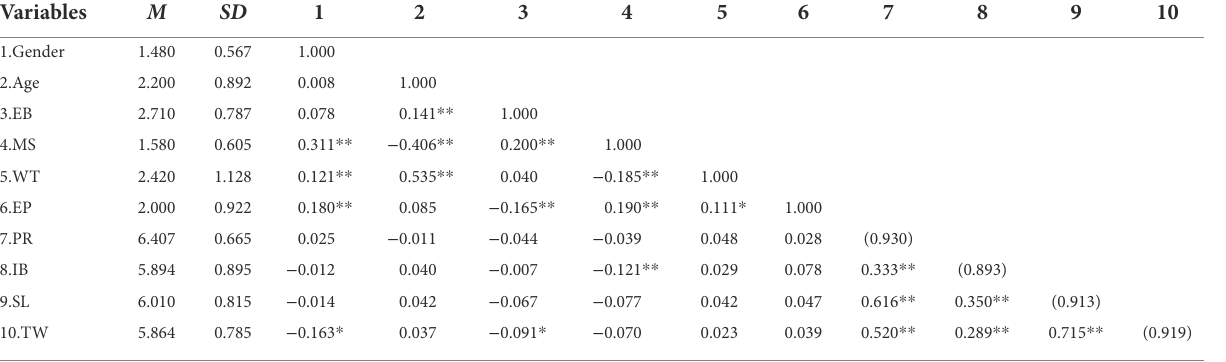
TABLE 2 Descriptive statistics and correlation coefficient. Variables